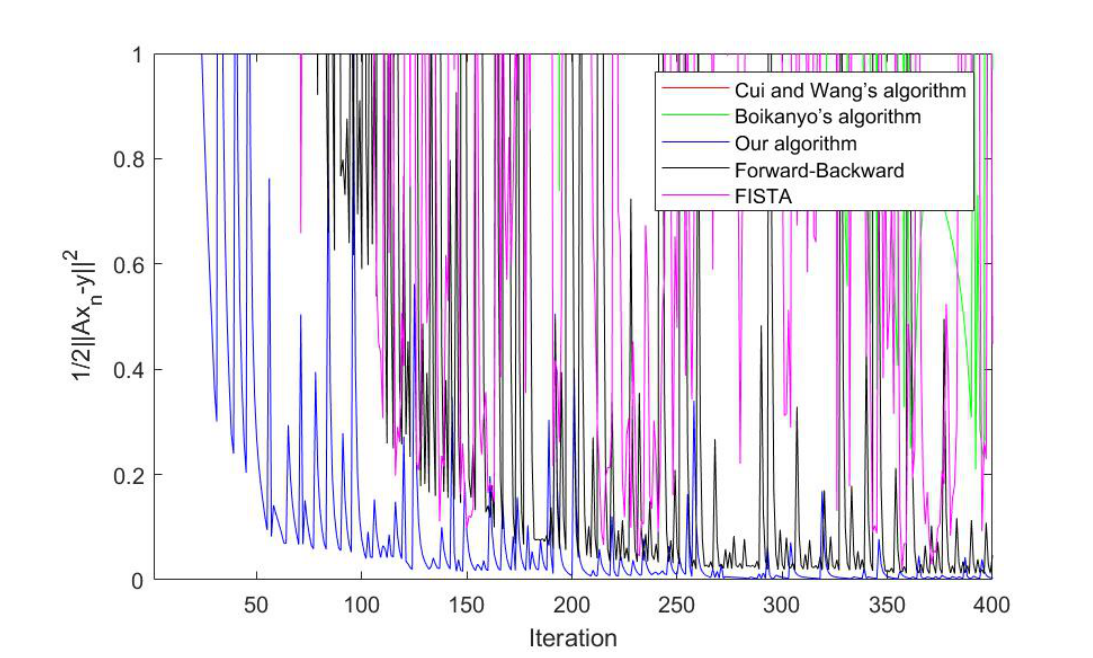
Figure 5. Case N = t = 100 and k =